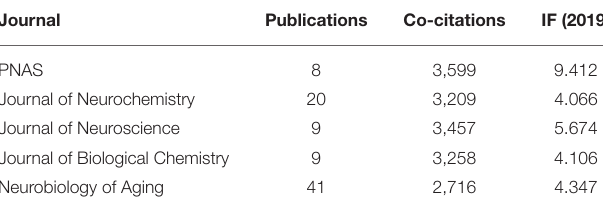
TABLE 4 | Top five co-cited journals.